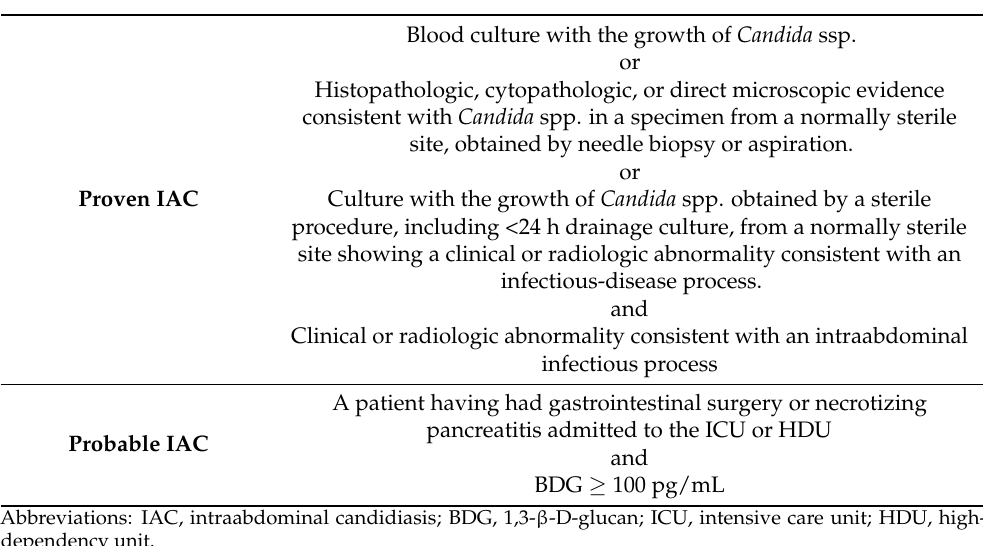
Table 1. Definition of proven IAC and probable